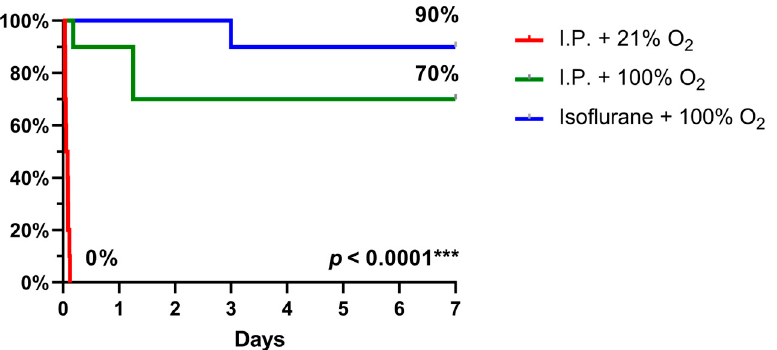
Figure 9. 7-day survival, assessed by Kaplan–Meier analysis, revealed a significant benefit with ox- ygen supplementation and even more with isoflurane anesthesia. ( n = 10/group). I.P.: